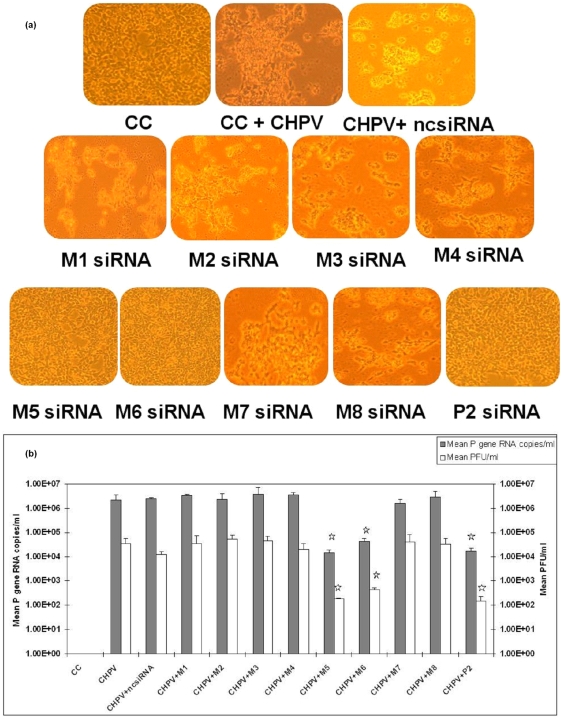
Validation of P-2 and M gene siRNA with CHPV.(a) Inhibition of CHPV induced cytopathic effects by siRNAs as observed by phase-contrast microscopy (10X). (b) Effect of different siRNAs on the replication of CHPV as determined by real time one step RT-PCR and plaque assay.Results are expressed as means ± SD. * indicates significantly different from control at p<0.05 by Dunnett's test.